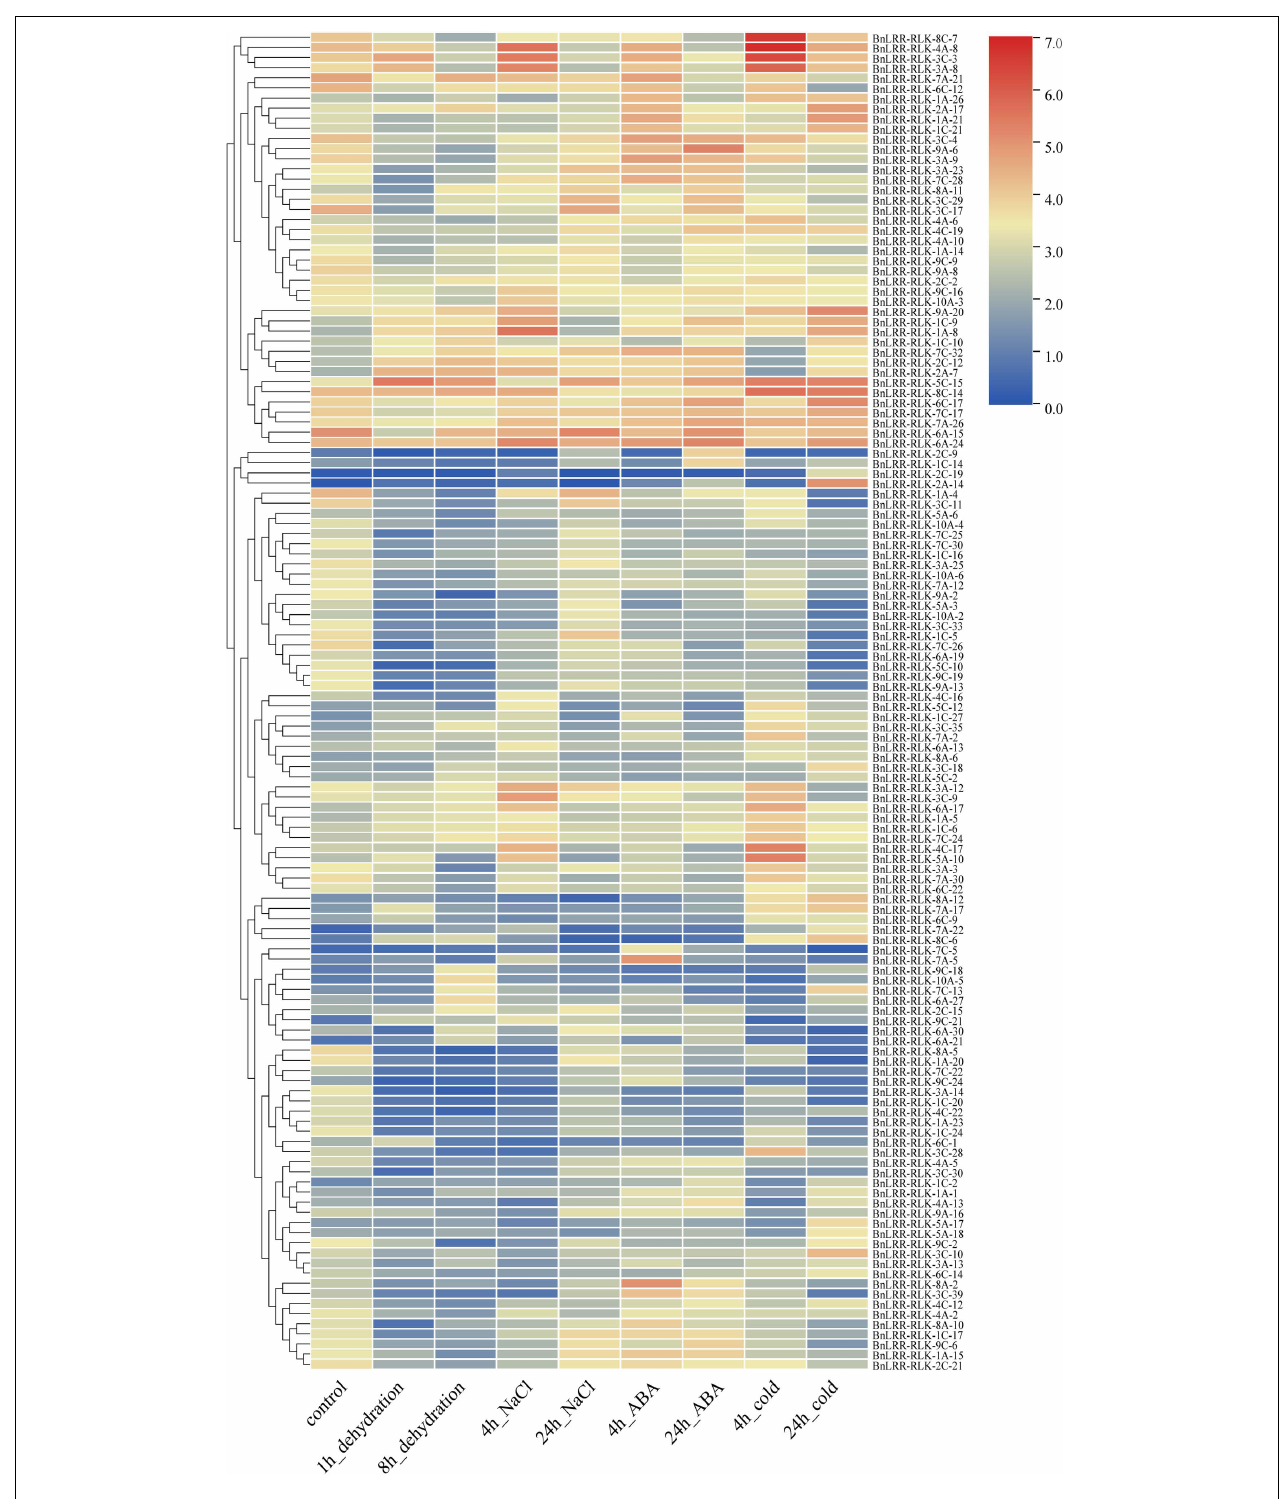
FIGURE 4 | Expression profiles of BnLRR-RLKs under different stresses. Leaf RNA-seq data for ZS11 under abiotic stress, namely dehydration, salt, ABA and cold stress treatments, was downloaded from the NGDC database. Expression level is equal to the mean values and transforms log2 values for normalization. Colors from blue to red represent relative expression levels from low to